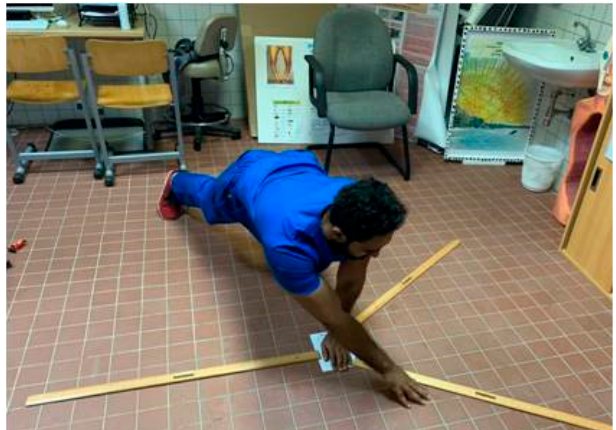
Figure 2. Upper-quarter Y-balance test.